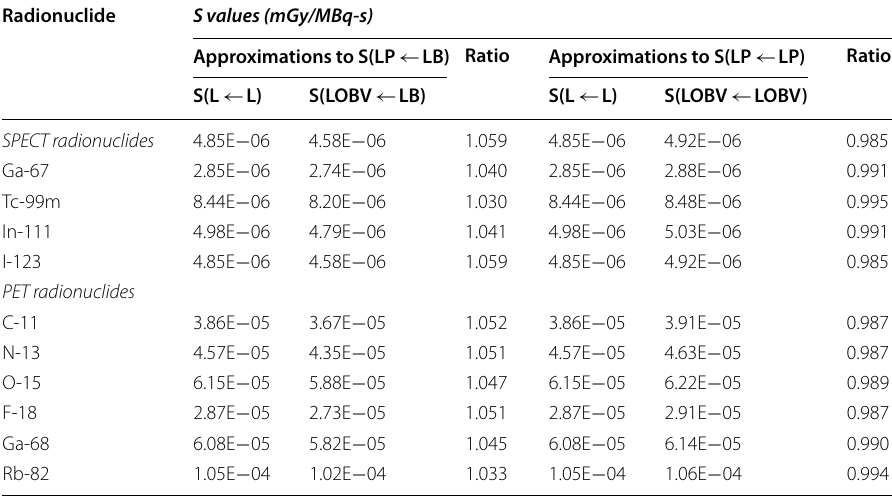
Table 7 Approximations of S ( LP ← LB ) and S ( LP ← LP ) values for 10 radionuclides with applications to diagnostic imaging using the single‑region and dual‑region tetrahedral mesh models of the reference adult male liver